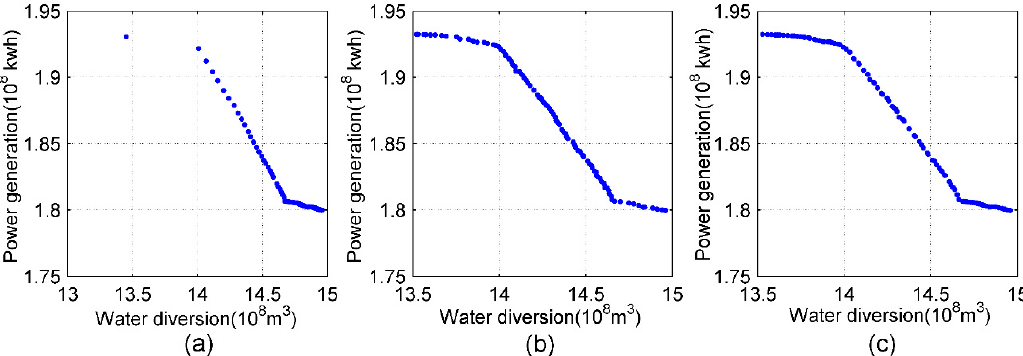
Figure 4. Pareto fronts of different algorithms for the proposed MORO problem: ( a ) Pareto front of MOEA/D; ( b ) Pareto front of NSGA-II; ( c ) Pareto front of MOEA/D-AWA.